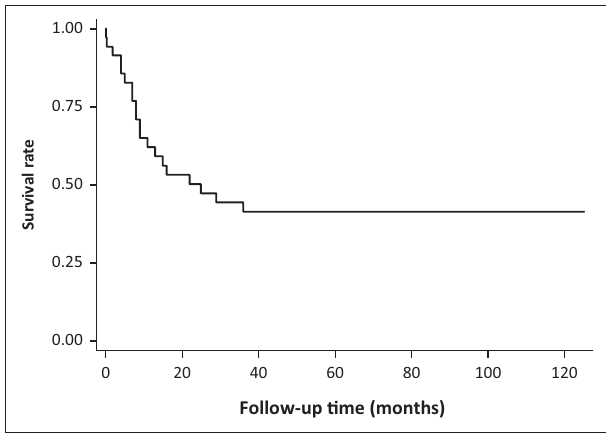
FIGURE 1: Kaplan–Meier overall survival estimate. FIGURE 2: Kaplan–Meier survival by surgical stage